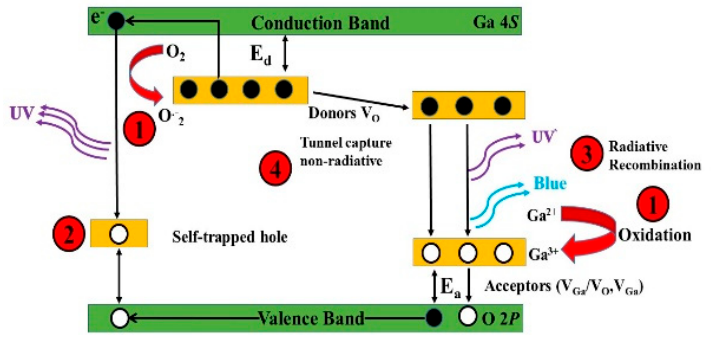
Figure 6. The paradigm of β -Ga 2 O 3 during the O 2 annealing process.